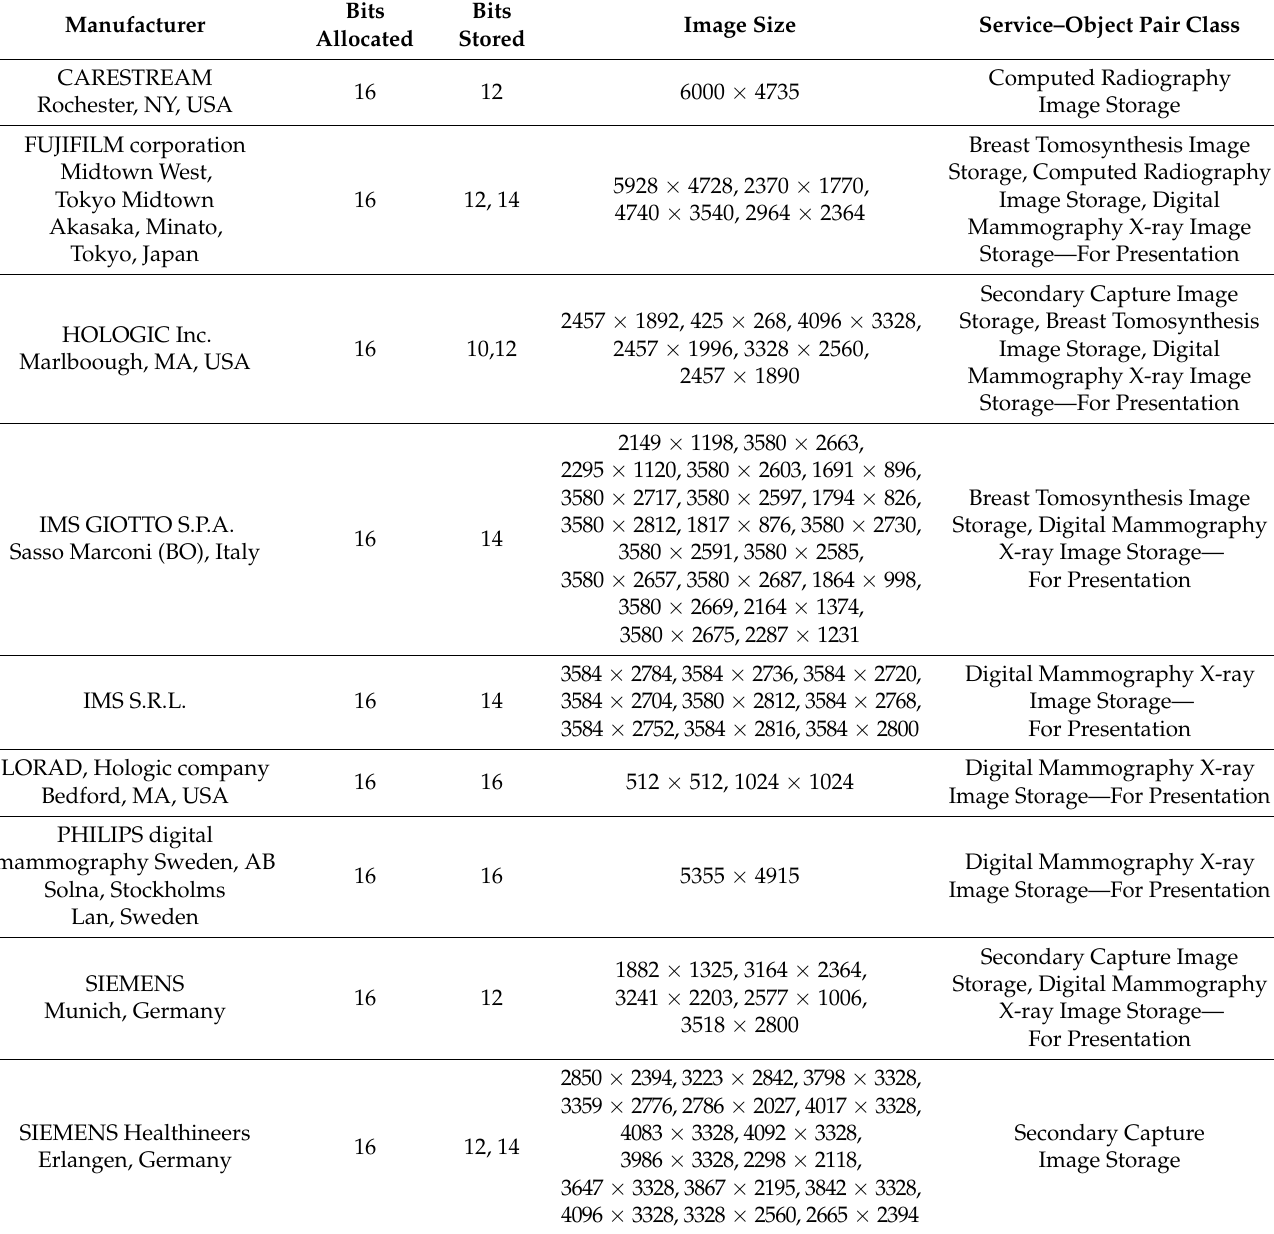
Table 4. Illustration of heterogeneity of MG images in the INCISIVE retrospective database with respect to manufacturer, number of bits available and used, image size and